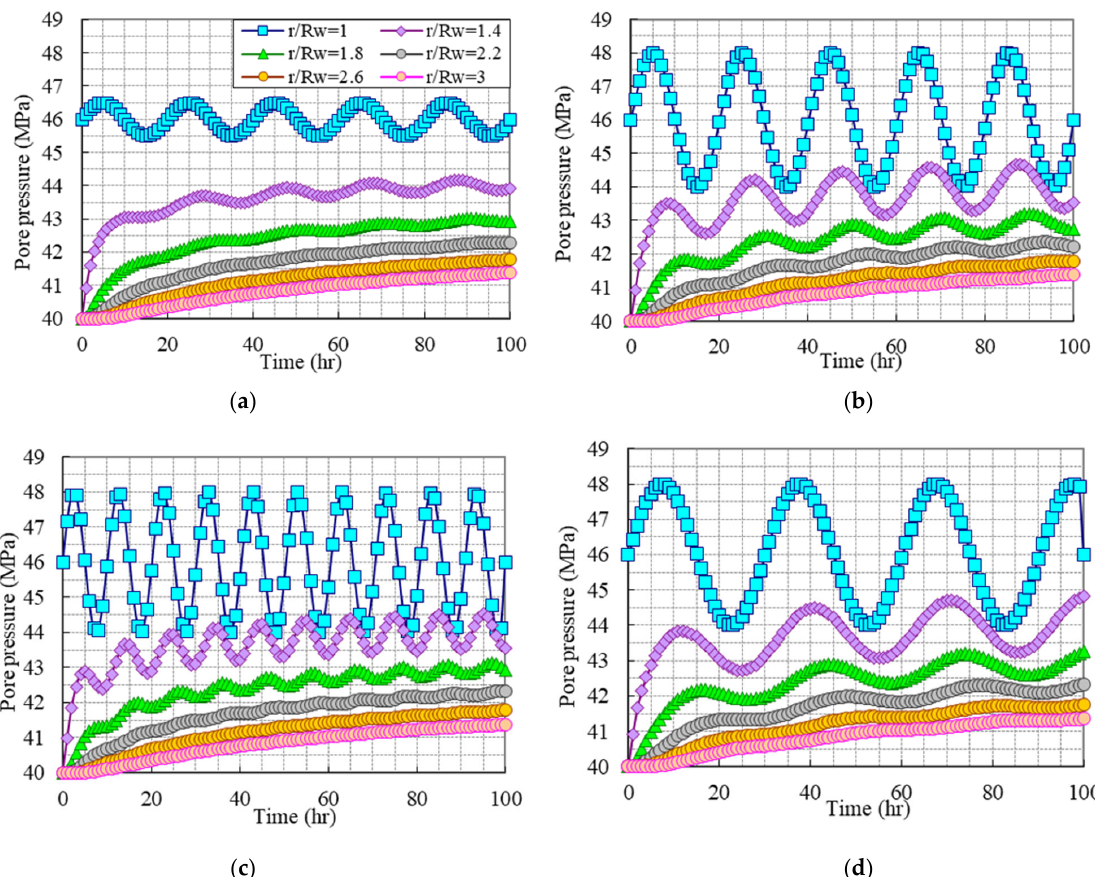
Figure 1. Variation of pore pressure over time at different locations around the well under pressure variations. ( a ) Amplitude 0.5 MPa, period 20 h; ( b ) Amplitude 2 MPa, period 20 h; ( c ) Amplitude 2 MPa, period 10 h; ( d ) Amplitude 2 MPa, period 30 h.